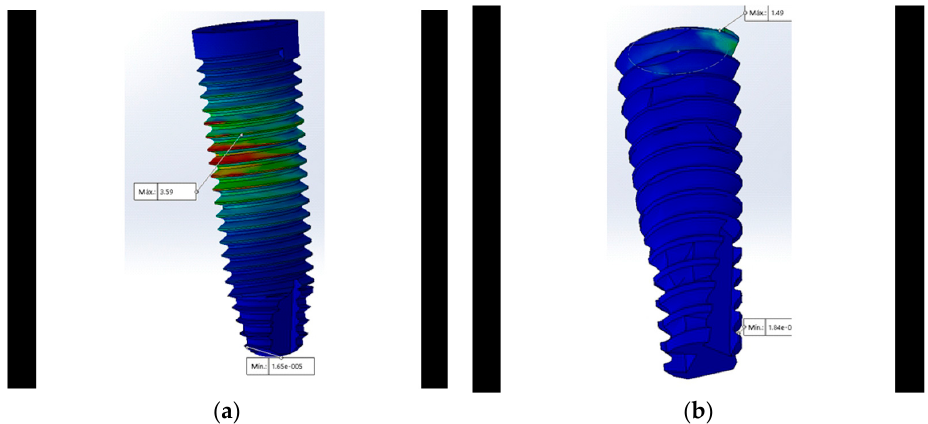
Figure 5. Maximum stress with 350 N in the implant is represented by the color red using the von Mises scale: ( a ) Maximum stress at the center in the MT connection; ( b ) maximum stress at the neck of the CT was lower (represented by the green color).